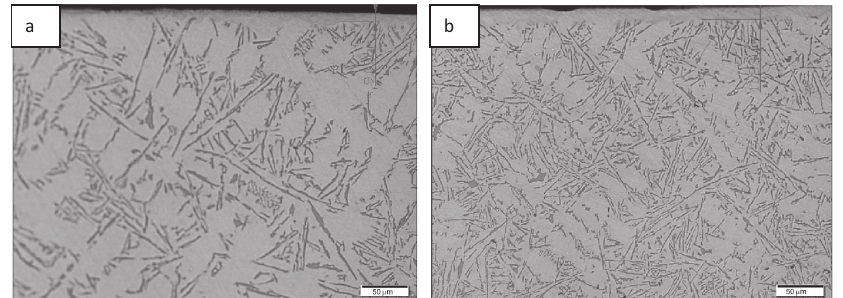
Figure 3: Cross-sectional SEM images of hypoeutectic Al – 10Si alloy after HCPEB treatment: (a) 5 pulses and (b) 15 pulses.